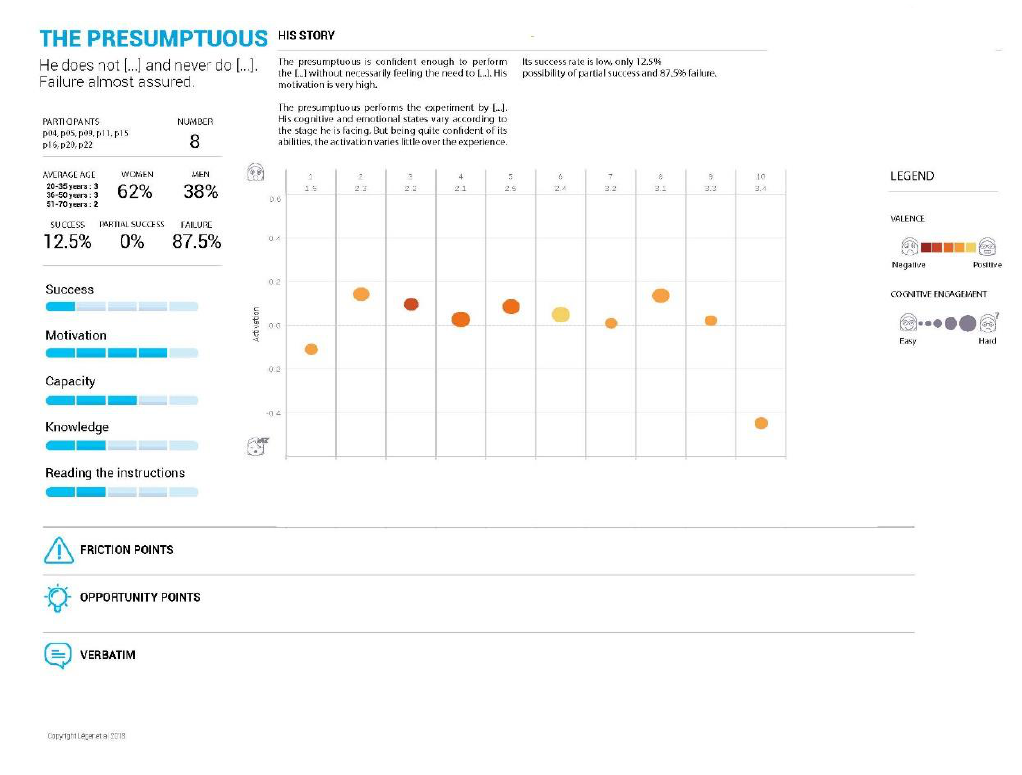
Figure 13. CJM of the Presumptuous.